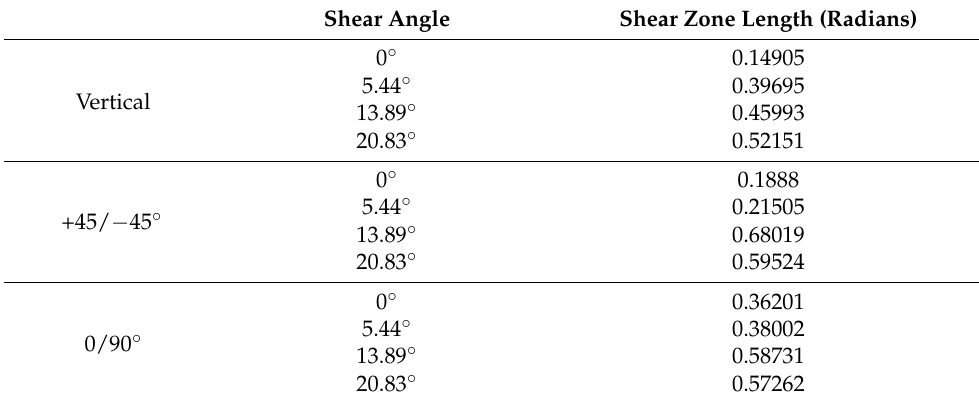
Table 3. Shear zone length of all three specimen